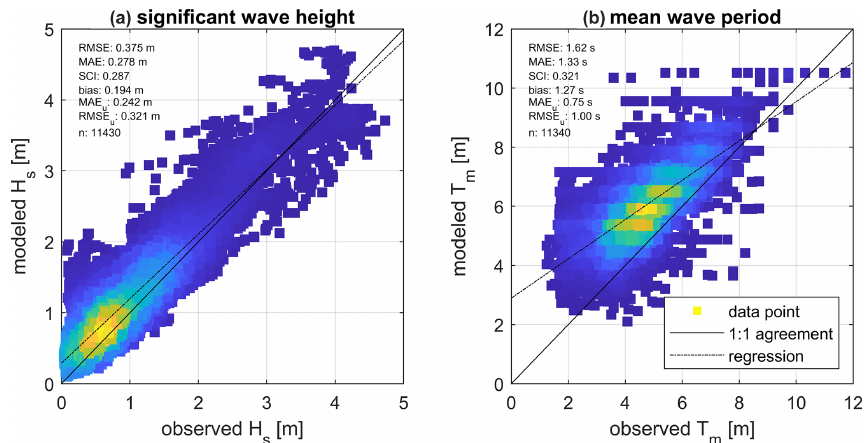
Figure 8. Scatter density plots of the modeled and observed wave parameters for > 10000 timestamps for the combined dataset of observa- tions collected between 2007–2013 for the intermediate domain. (a) Significant wave height and (b) mean wave period.